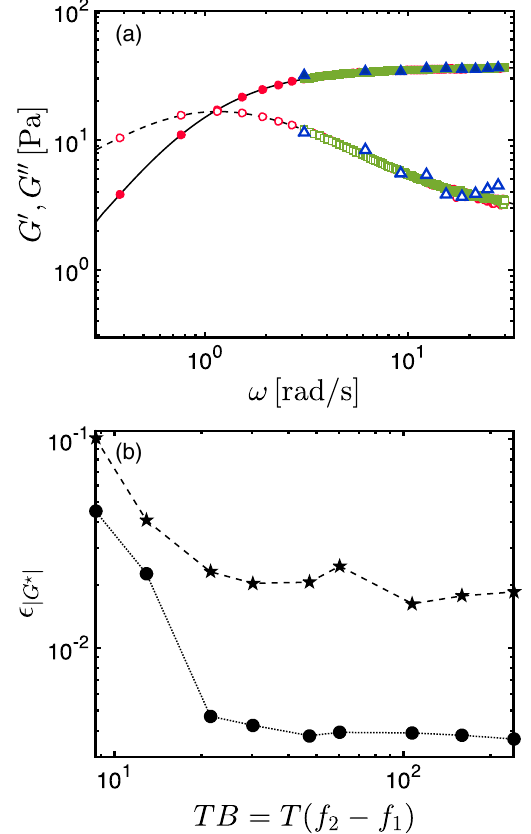
FIG. 7. (a) Viscoelastic moduli of the CPyCl micellar solution. Reference values ( G 0 , line; G 00 , dashed line) are measured with a sequence of sine steps at different frequencies. A comparison between results measured using optimally windowed chirps ( r ¼ 10% ) with two different time-bandwidth products obtained by changing only the length of the signal T : TB ¼ 8 . 6 ( G 0 , blue filled triangle; G 00 , blue triangle) and TB ¼ 107 ( G 0 , green filled square; G 00 , green square). The frequency range is kept constant with ω 1 ¼ 3 rad = s and ω 2 ¼ 30 rad = s to guarantee a consistent comparison between chirps of different durations. Results ob- tained using a separate optimally windowed chirp ( r ¼ 10% ) with the frequency range adjusted to the length of the signal ( T ¼ 14 s, ω 0 . 3 rad = s, ω 30 rad = s, and TB ¼ 66 ) are also reported 1 ¼ 2 ¼ withcircles ( G 0 ,redfilled circle; G 00 ,redcircle).The nominalstrain for all signals (sine steps and chirps) is γ 0 ¼ 6% . (b) Trends of the error for the magnitude of the complex modulus as a function of varying time-bandwidth constant TB for an optimally windowed chirp with r ¼ 10% . Results for both the PIB solution (dot filled circle) and the micellar solution (dash filled star) are